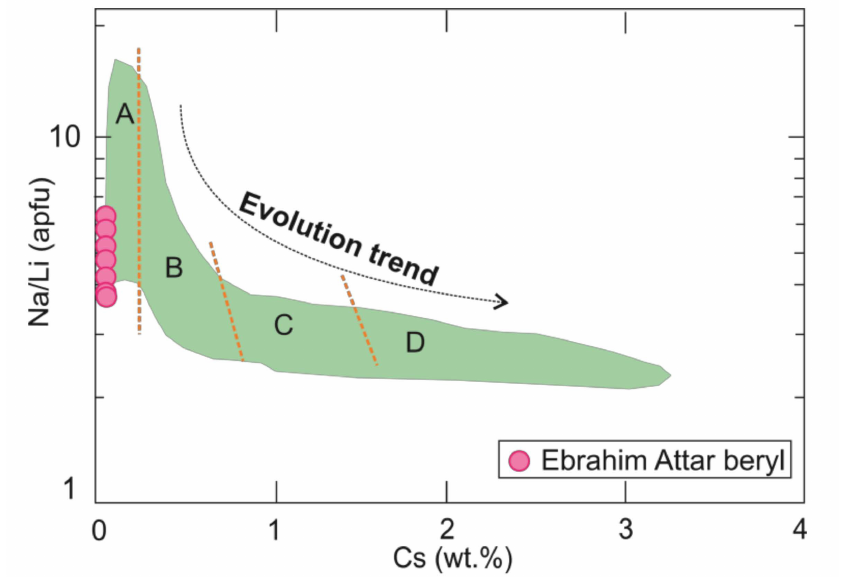
Figure 10. Diagram of Na/Li vs. Cs to compare the geochemical compositions of Ebrahim-Attar beryl with magmatic trend proposed by Trueman and Cerny [73] and divided pegmatite into four groups: (A) barren and geochemically primitive beryl type and less-evolved pegmatite; (B) geochemically evolved beryl-columbite and beryl- columbite-phosphate pegmatite; (C) albite-spodumene and complex pegmatite; (D) highly fractionated Li, Cs, and Ta-rich complex pegmatite. The beryl samples are plotted in less-evolved